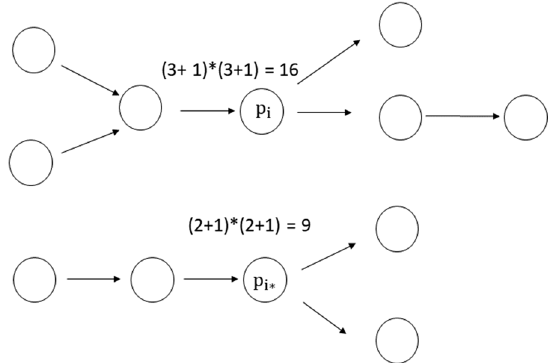
Fig. 5 Illustration of the SPNP index and randomization process. Notes : Assume patent p i is the actual observed one in the citation network. It has received one direct backward citation, two indirect backward citations along the incoming paths and two direct forward citations and one indirect forward citation along the outgoing paths. Together with the added constants of one, this results in a SPNP of sixteen. In contrast, patent p i ∗ has randomly created backward and forward paths. By construction, it has the same number of backward and forward citations as patent p i . But in the example the randomly assigned backward cited patent only cites one patent and the randomly assigned forward cited patents were not cited at all. This results in a lower SPNP of nine